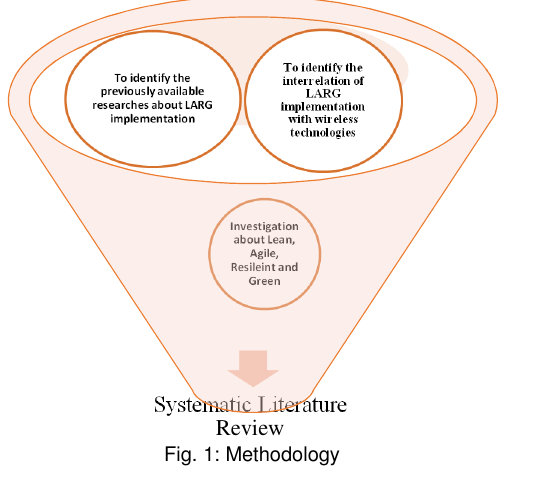
Fig. 1: Methodology